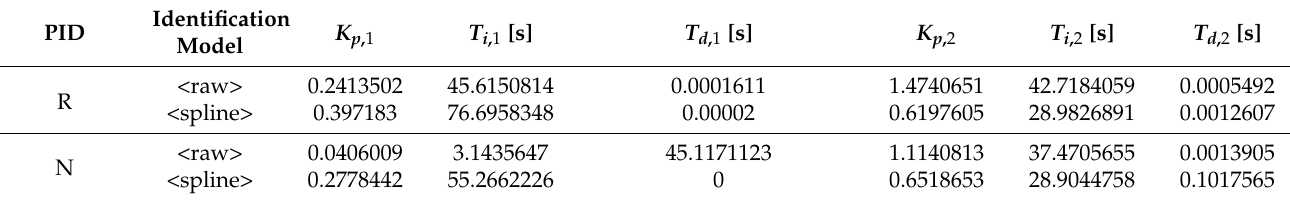
Figure 18. I/O signals for optimal PID-N controllers; in the case of <spline> idmo, Φ IFA o = 85.07%. Table 5. Parameters of optimal PID controllers found by means of